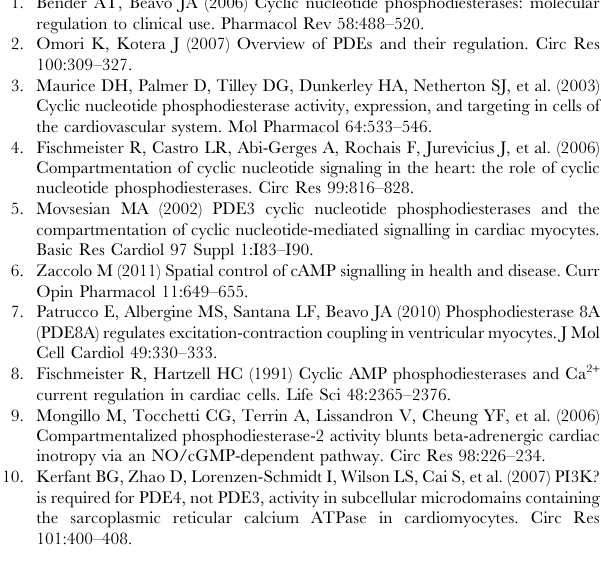
Figure S3 Effects of PDE3 inhibition with milrinone on L-type Ca 2 + current in right ventricular myocytes. A. Figure S4 Effects of PDE4 inhibition with rolipram on L-type Ca 2 + current in right ventricular myocytes. A.